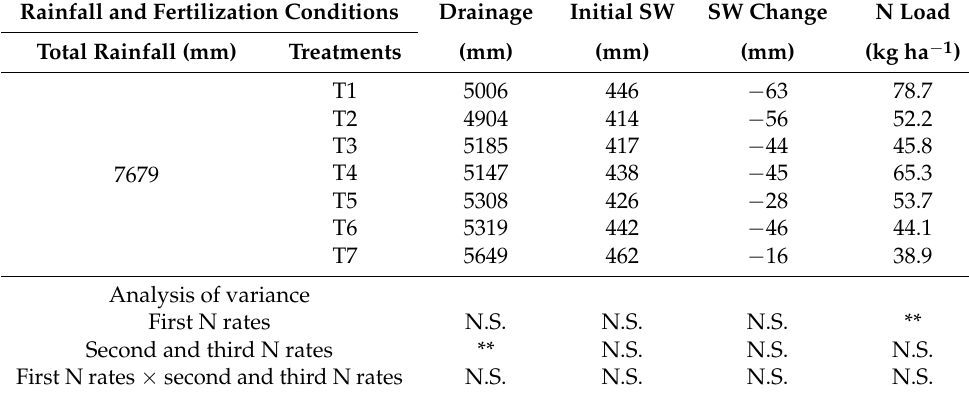
Table 6. Effects of reductions of the first, second, and third N fertilizer application rates on drainage, initial soil water in the beginning of the season (initial SW), soil water change (SW change), and N load in the whole